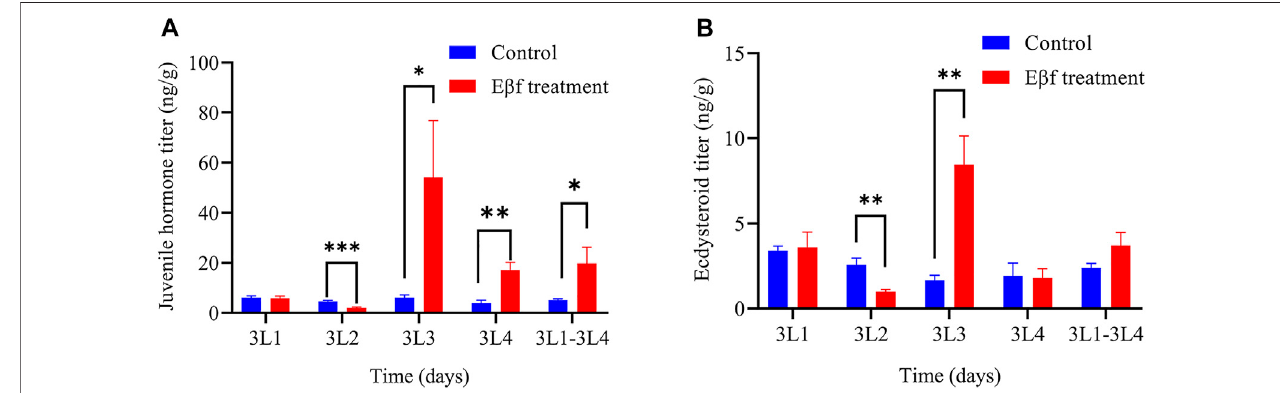
FIGURE5| EffectofE β ftreatmentoninsecthormonetitersin3rdinstar C.suppressalis larvae. (A) Juvenilehormonetiter. (B) Ecdysteroidtiter.Valuesaremeans± SEM of three replicates. Asterisks indicate signi fi cant differences: * p < 0.05; ** p < 0.01; *** p < 0.001 (Mann-Whitney U test).